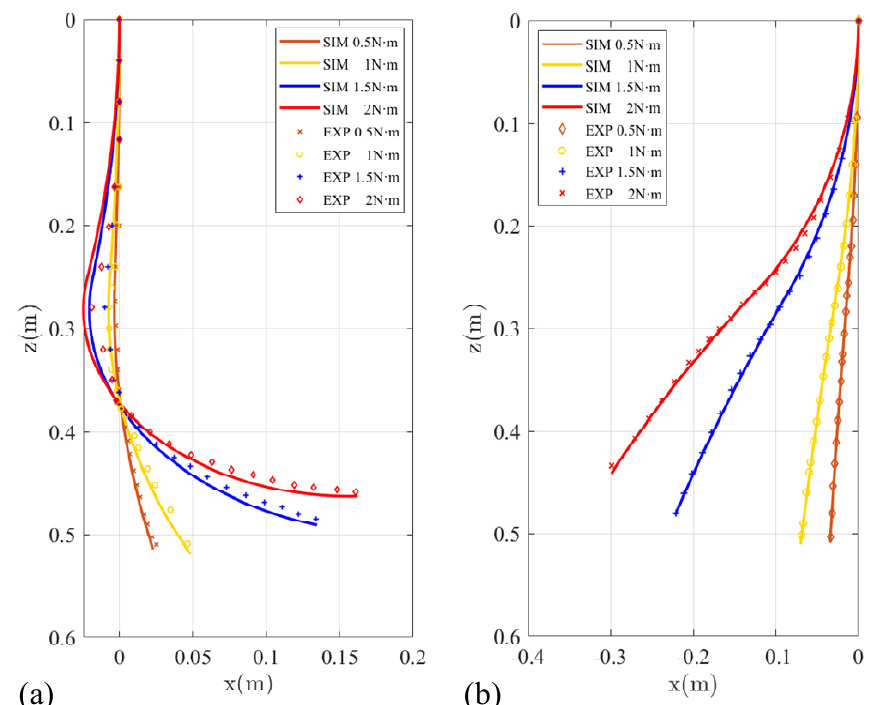
Figure 10. The steady state posture of the soft manipulator under different driving pressures.